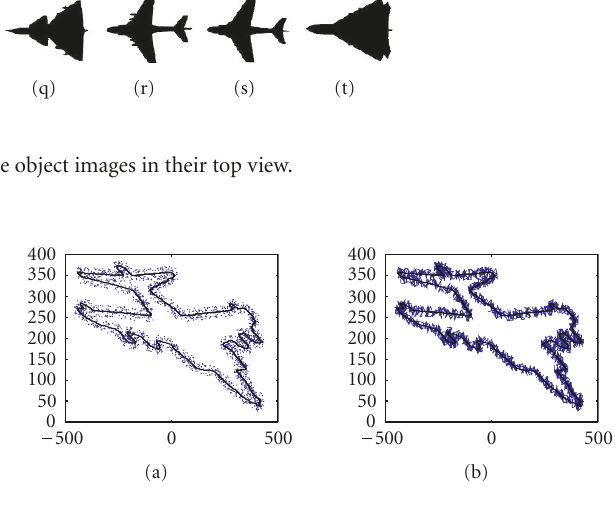
Figure 3: The noisy boundary of object (i) at SNR = 20dB con- nected with (a) points and (b)